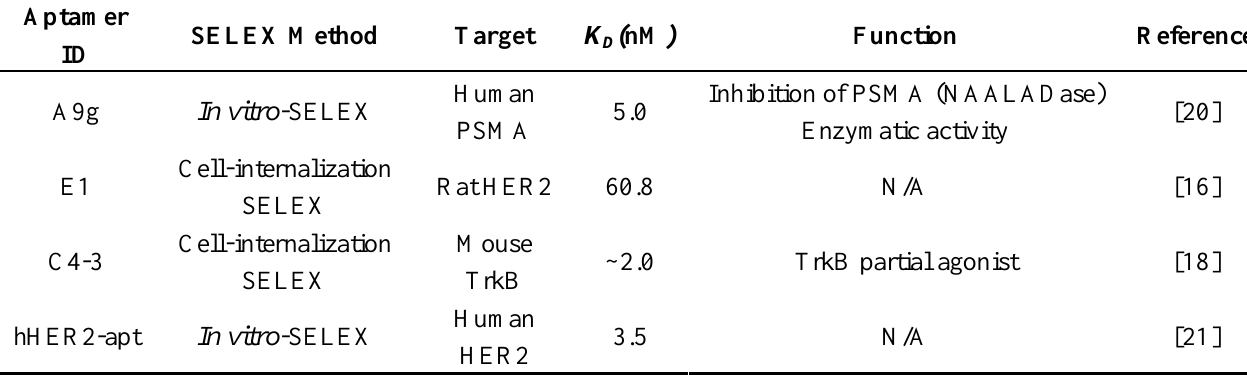
Table 1. List of aptamers used in this